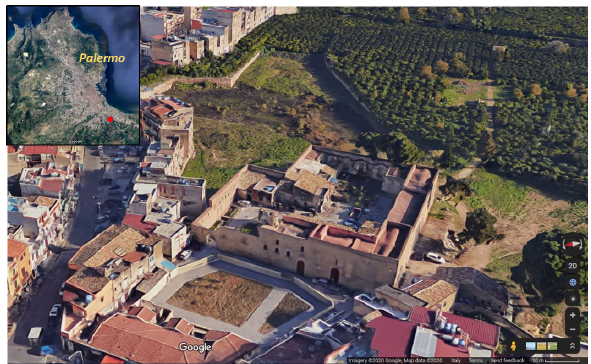
Figure 1. The Castle of Maredolce (image from Google Maps©); unauthorized structures are still visible in this image.